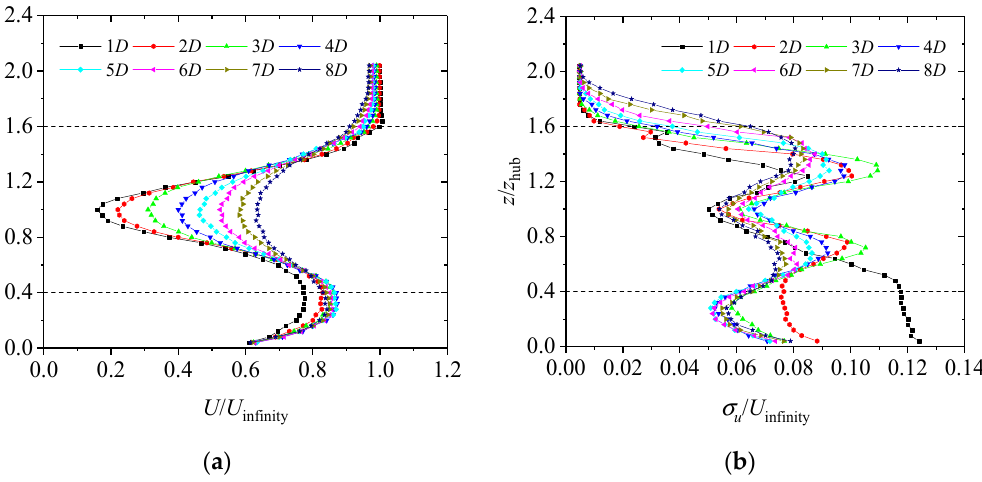
Figure 7. Wake distributions with various locations in the hub center vertical plane (flat terrain). ( a ) Mean velocity; ( b ) turbulence intensity.